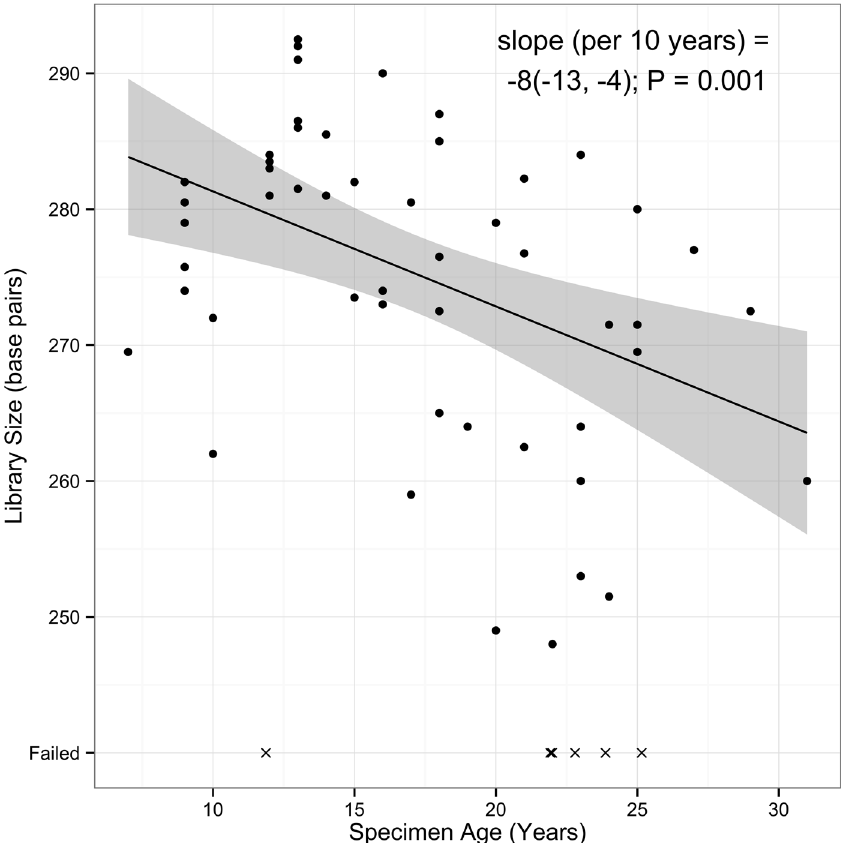
Fig 3. Association between specimen storage time and final library size in base pairs. Specimens that failed sequencing do not have library size values and are indicated by x. The solid line indicates the estimated linear relationship between storage time and library size (N = 59). The shaded area denotes pointwise 95% confidence intervals for the conditional means. Cases successful through the entire WES workflow (DNA extraction through WES sequencing) are denoted as circles (N = 53); unsuccessful cases are denoted as X ’ s (N = 6). Failed assays were not used to estimate the linear